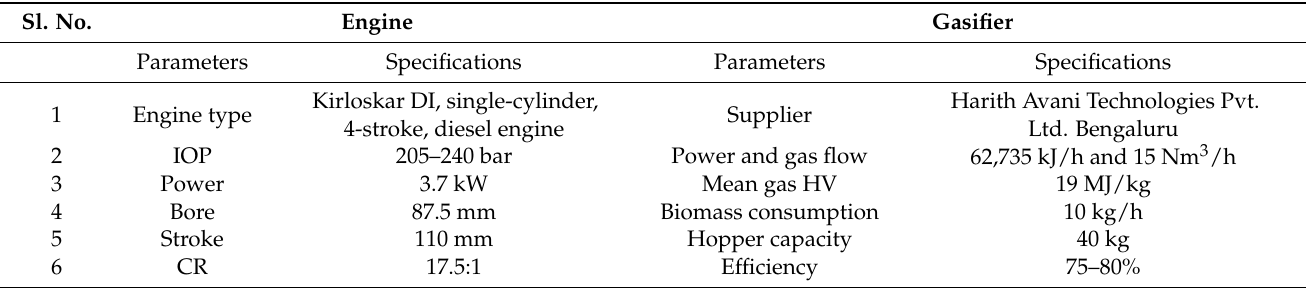
Table 3. Specifications of engine and gasifier